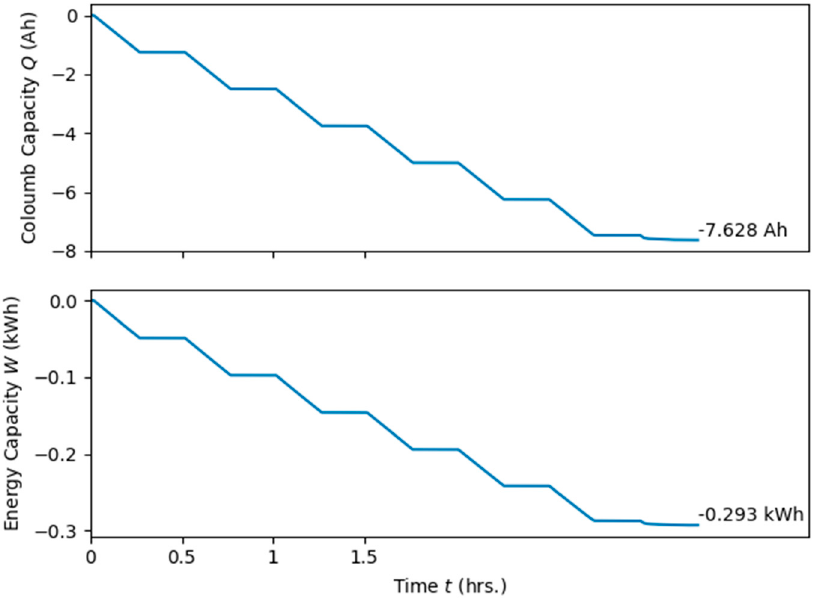
Figure 17. Capacity measured during the test.